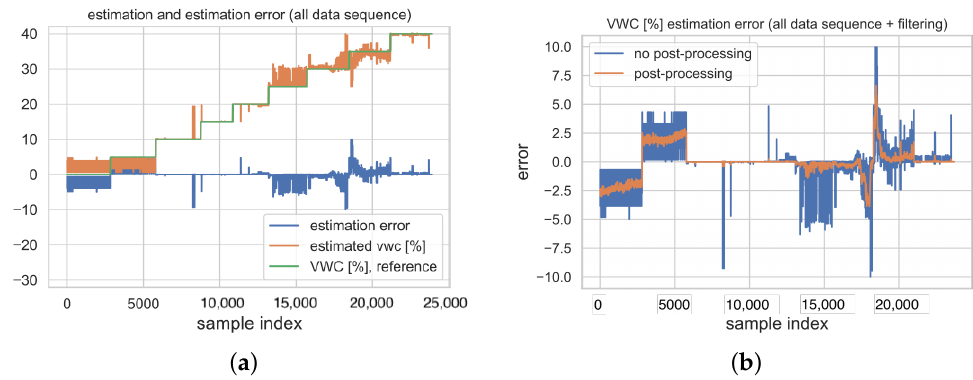
Figure 11. Effect of data post-processing (i.e., Savitzky–Golay filtering) for the augmented sensor (i.e., the one taking as input both raw readings and RSSIs) on the test set: ( a ) sequence of VWC estimates and estimation errors for the unfiltered model, and ( b ) comparison between estimation errors with and without filtering.